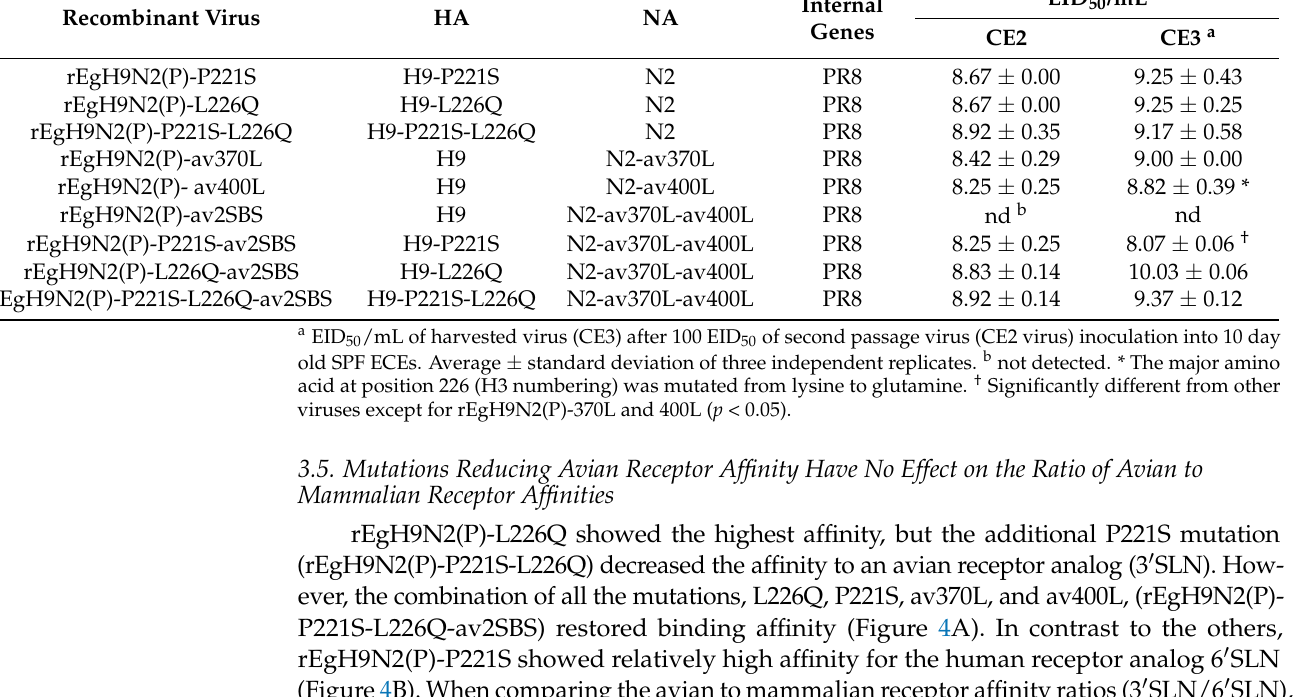
Table 3. Genomic compositions and virus titers of PR8-derived recombinant Egyptian H9N2 strains. Recombinant